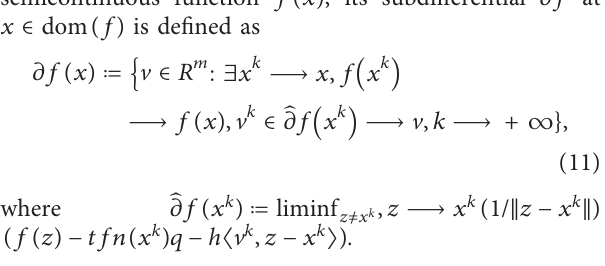
and Log-function scad